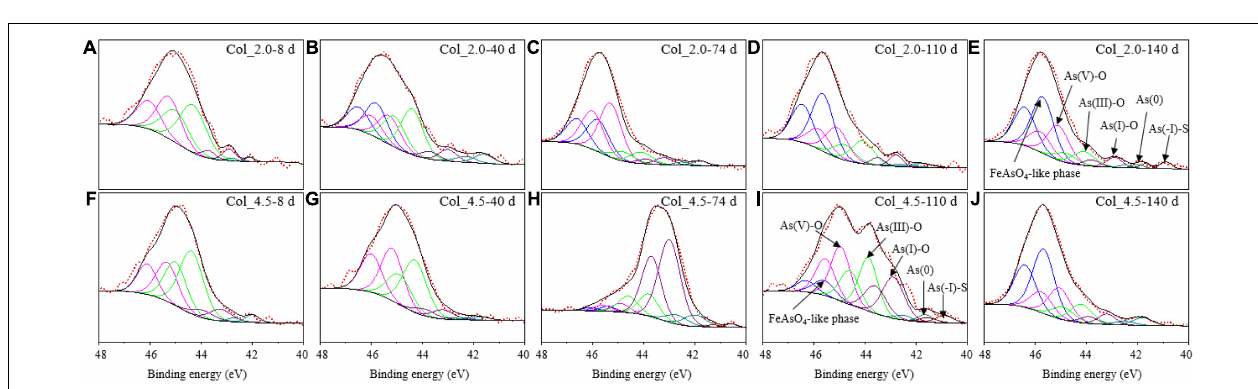
FIGURE 6 | XPS spectra for the surface S of the bottom residues during cultivation without (A–E) and with additions of 2.0 mM (F–J) and 4.5 mM (K–O) As(III) on days 8 (A,F,K) , 40 (B,G,L) , 74 (C,H,M) , 110 (D,I,N) , and 140 (E,J,O) .